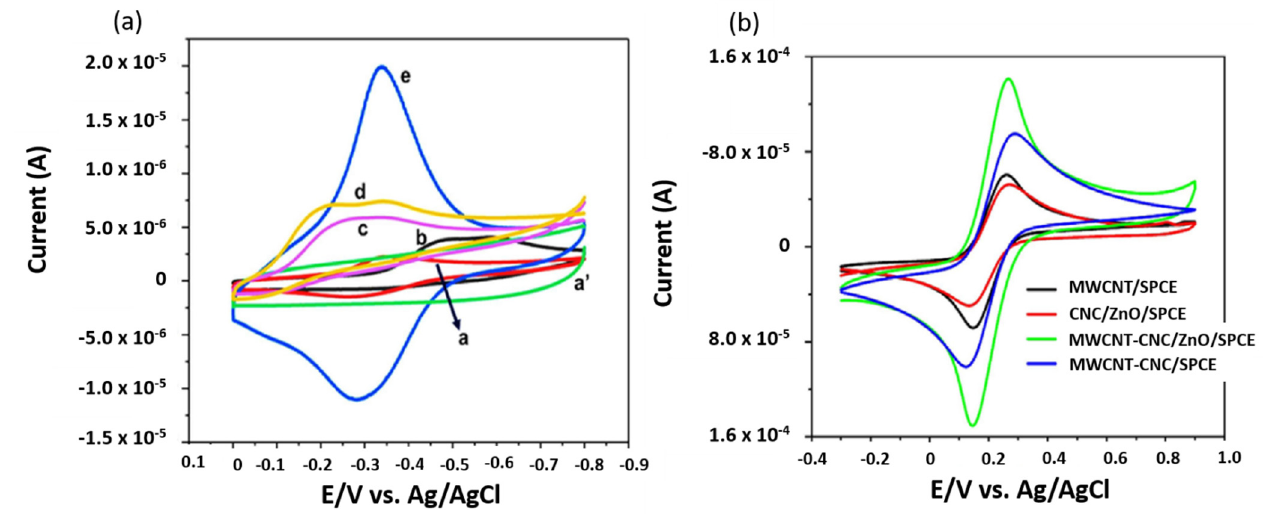
Figure 15. ( a ) Cyclic voltammogram obtained for hemin immobilized different modified SPCEs, hemin/SPCE ( a ) CNC/ZnO NR/hemin/SPCE, ( b ) MWCNT/hemin/SPCE, ( c ) MWCNT-CNC/hemin/SPCE ( d ) and MWCNT-CNC/ZnO NR/hemin/SPCE ( e ) in a deoxygenated pH 7.0 at a scan rate of 100 mV/s. Under the same conditions, MWCNT-CNC/ZnO NR modified SPCE in the absence of hemin ( a’ ), ( b ) Cyclic voltammetric response and the electron transfer characteristics of MWCNT-CNC/ZnO NR, CNC/ZnO, MWCNT-CNC and pristine MWCNT modified SPCEs in 5 mM potassium ferricyanide containing 0.1 M KCl. Adapted from ref. [119].